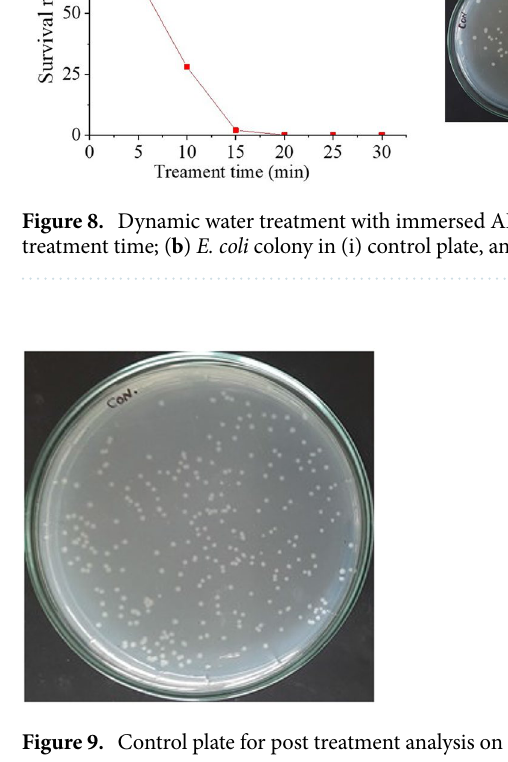
Figure 9. Control plate for post treatment analysis on APPJR treated